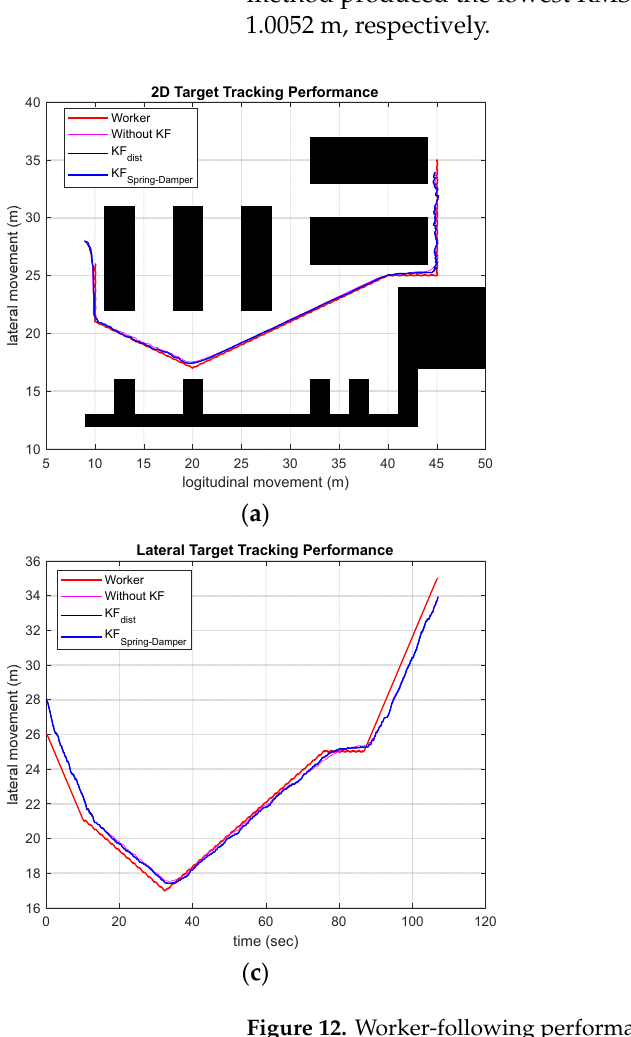
Figure 11. Control inputs for the MWR: ( a ) Linear and angular speed of the robot; ( b ) Rotational speed of Mecanum wheel motor.